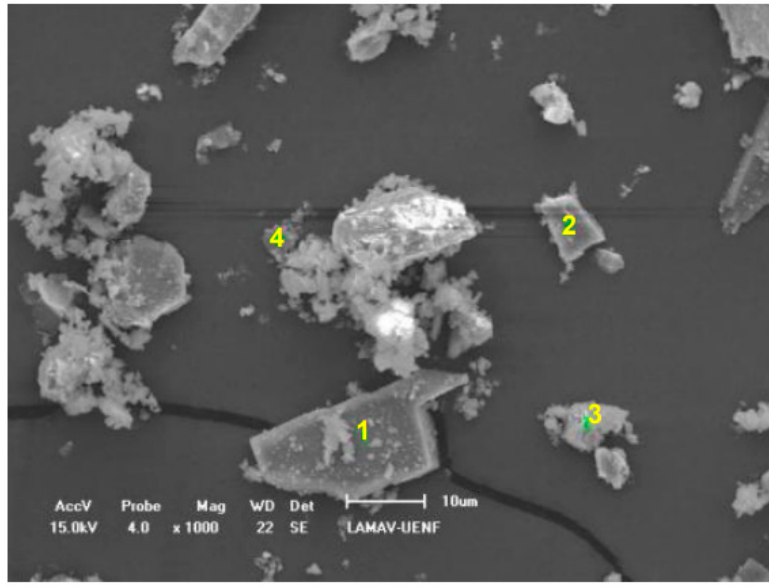
Figure 5. Morphological analysis of the granite residue by scanning electron microscopy (SEM). Table 2. Chemical composition of the granite residue (%).